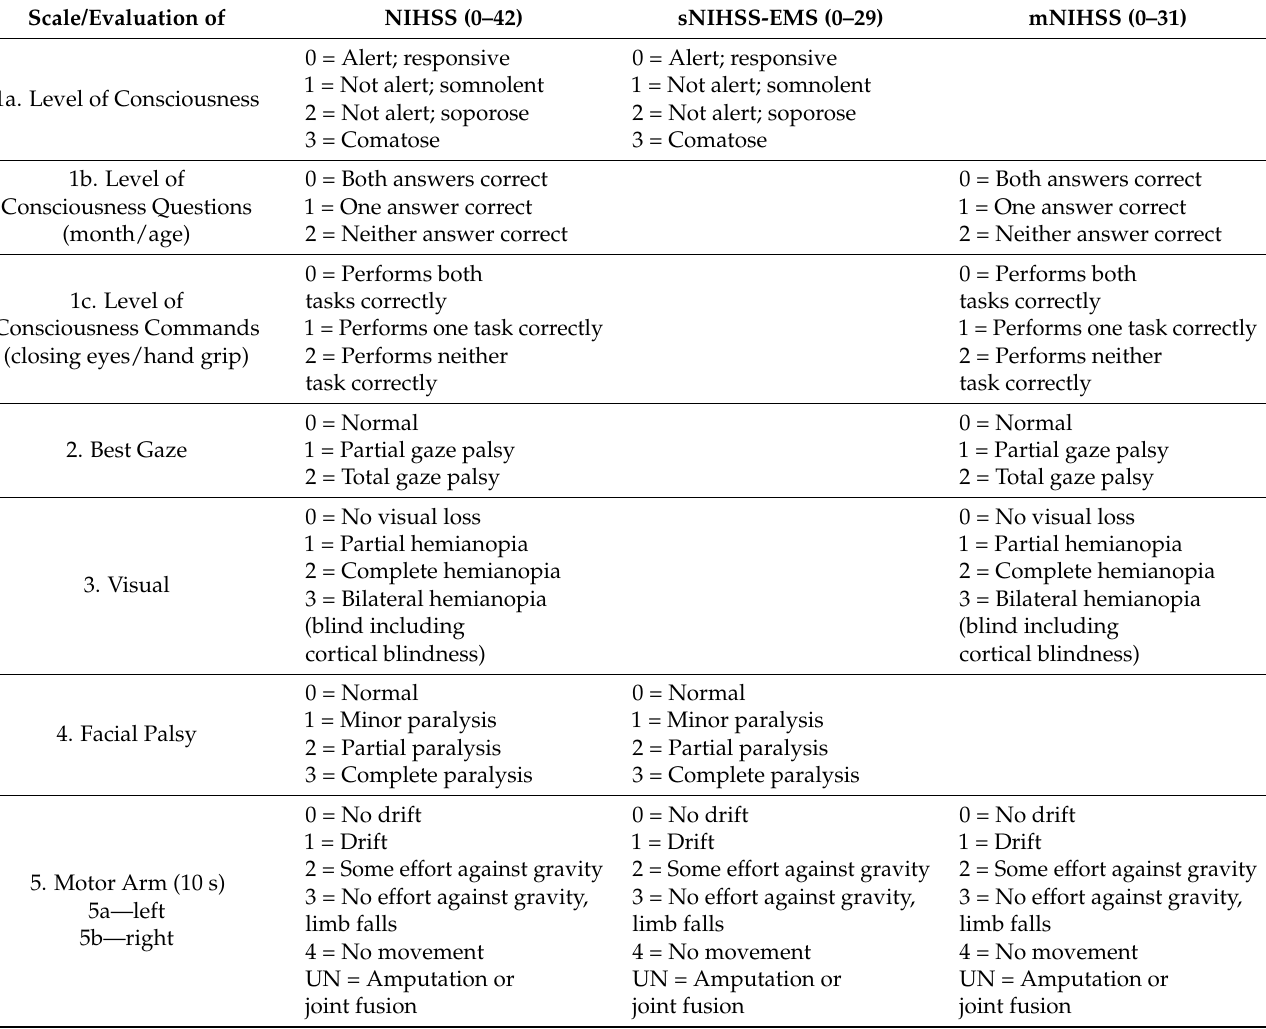
Table 2. The National Institutes of Health Stroke Scale variants [16,23,32–35]. Scale/Evaluation